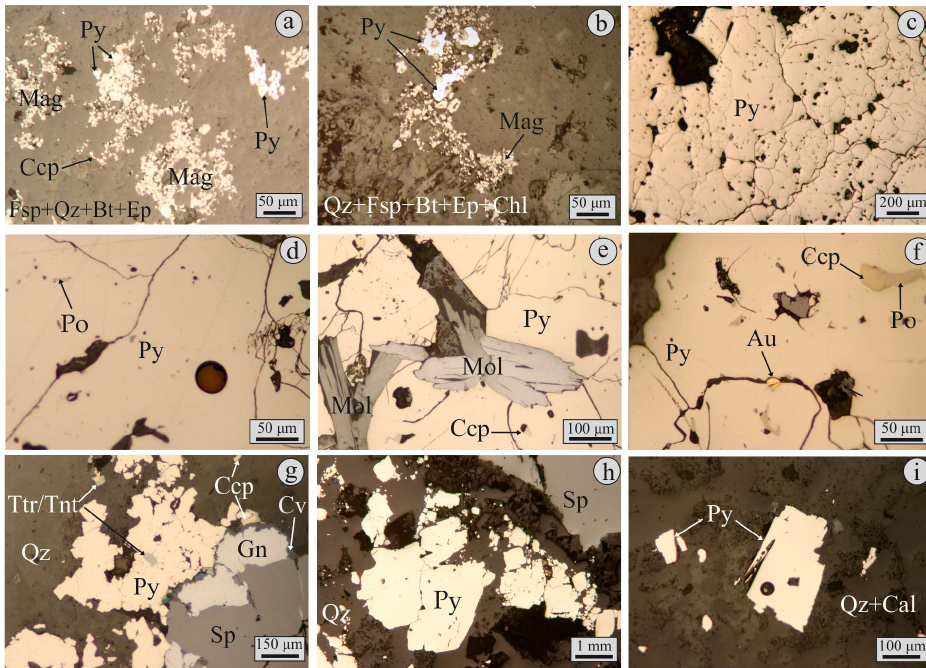
Figure 7. Reflected light photomicrographs of pyrite and associated opaque minerals from different mineralization events in the Pagoni Rachi prospect. ( a ) Fine grained magnetite (Mag) in association with pyrite (Py) and chalcopyrite (Ccp), in calcic/potassic matrix dominated by feldspar (Fsp, orthoclase, and/or albite), quartz (Qz), feldspar (Fsp, orthoclase, and/or albite) biotite (Bt) and epidote (Ep), M-type vein (sample KMPR74); ( b ) Magnetite (Mag) along with pyrite (Py) in sodic/potassic-calcic altered granodiorite porphyry, consisting of quartz (Qz), feldspar (Fsp, albite, and/or orthoclase), biotite (Bt), epidote (Ep), and chlorite (Chl), M-type vein, (sample KMPR68); ( c , d ) Massive, subhedral to anhedral pyrite (Py), including minor pyrrhotite (Po), D-type vein, (sample KMPR66). Note in ( d ) the black circle indicates the laser-ablation ICP-MS analysis spot; ( e ) Subhedral pyrite (Py) intergrown with molybdenite (Mol) and including minor chalcopyrite (Ccp), D-type vein (sample KMPR66); ( f ) Native gold (Au) associated with pyrite (Py), which includes pyrrhotite (Po) and chalcopyrite (Ccp), D-type vein (sample KMPR66); ( g ) Euhedral pyrite (Py) in association with galena (Gn), sphalerite (Sp), covellite (Cv), and fahlores (Ttr/Tnt), in quartz (Qz), E-type vein (sample KMPR53); ( h ) Coarse-grained, euhedral pyrite (Py) and sphalerite (Sp) in quartz (Qz), epithermal-style vein (sample KMPR53); ( i ) Pyrite grain included in a quartz (Qz) and calcite (Cal) dominated matrix. The black circle marks the laser-ablation ICP-MS analysis spot, E-type vein (sample KMPR53).